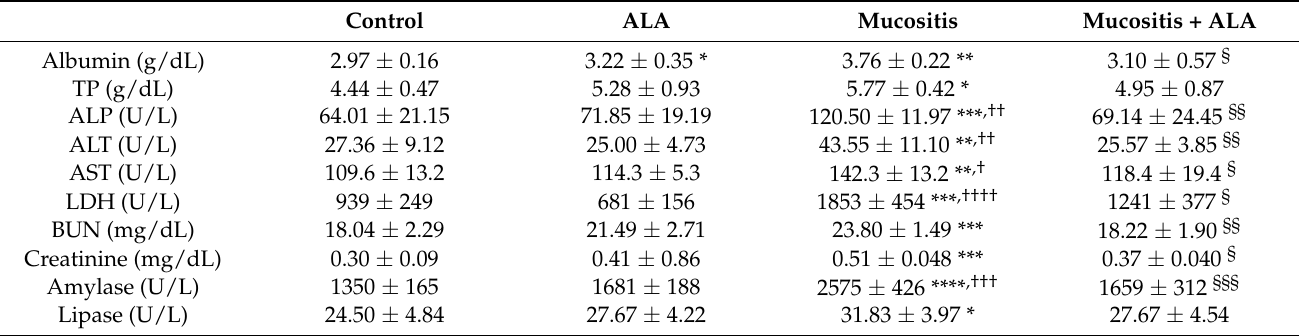
Table 1. Results of serum enzymes and metabolites in the sera of rats. Results are expressed as mean ±